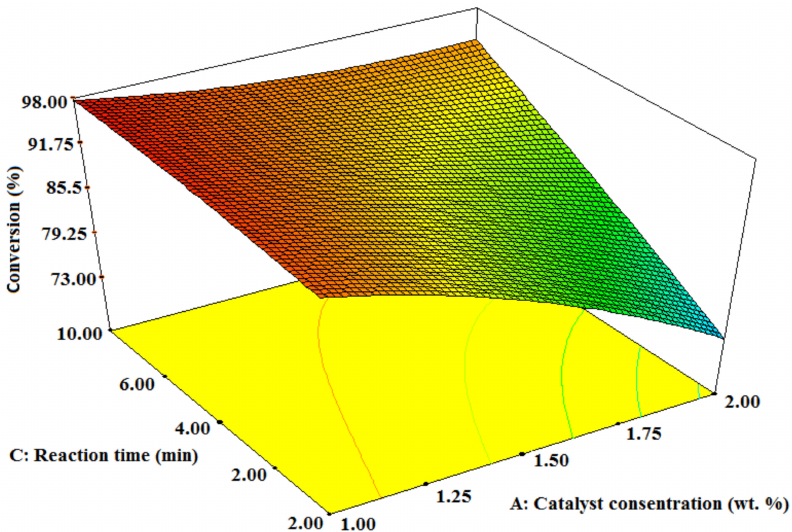
Figure 4. Catalyst concentration (wt %)—reaction time (min) on biodiesel conversion (%) when methanol to oil molar ratio equal to